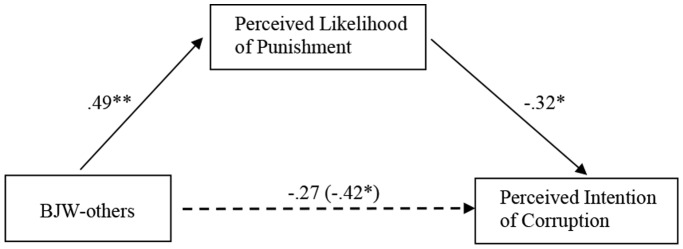
Hypothesized model linking BJW-others and corruption perception in brother condition as mediated by perceived likelihood of punishment in Study 2.
Note: Solid lines indicate paths significant at p<.05, whereas the dotted line indicates a non-significant path at p>.05 once perceived likelihood of punishment was added into the model. Parameter estimates are standardized regression coefficients (β). *p<.05. **p<.01.